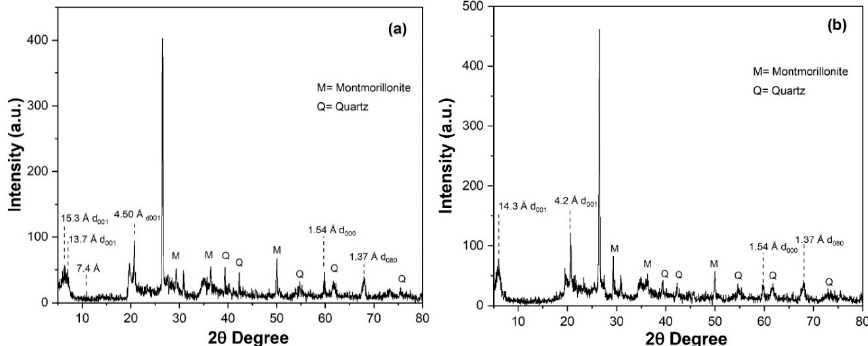
Figure 5. XRD pattern of: ( a ) Untreated montmorillonite clay; ( b ) Organo modified MMT clay.